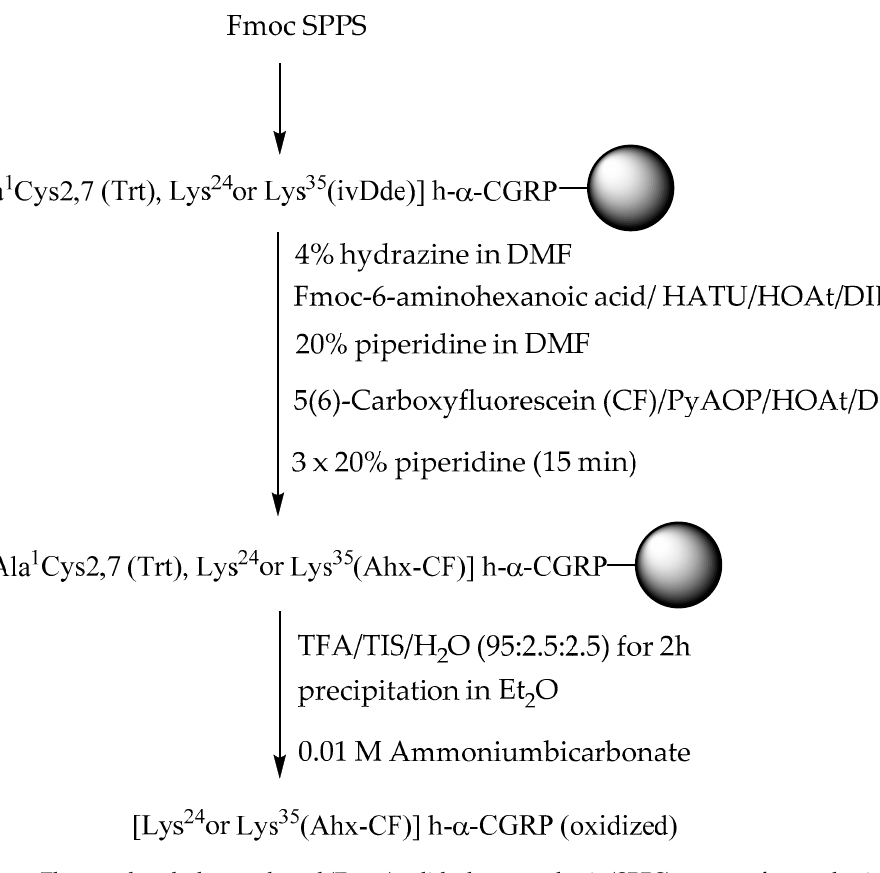
synthesizing fluorescent analogues of h- α